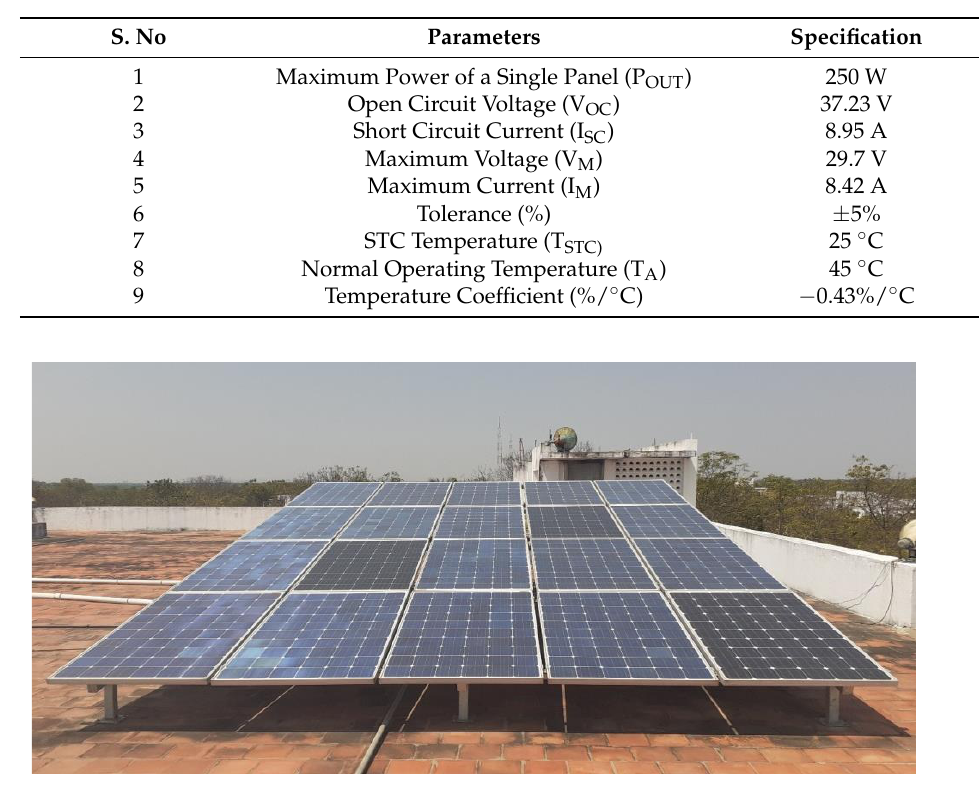
Figure 4. 5 kW PV Array.